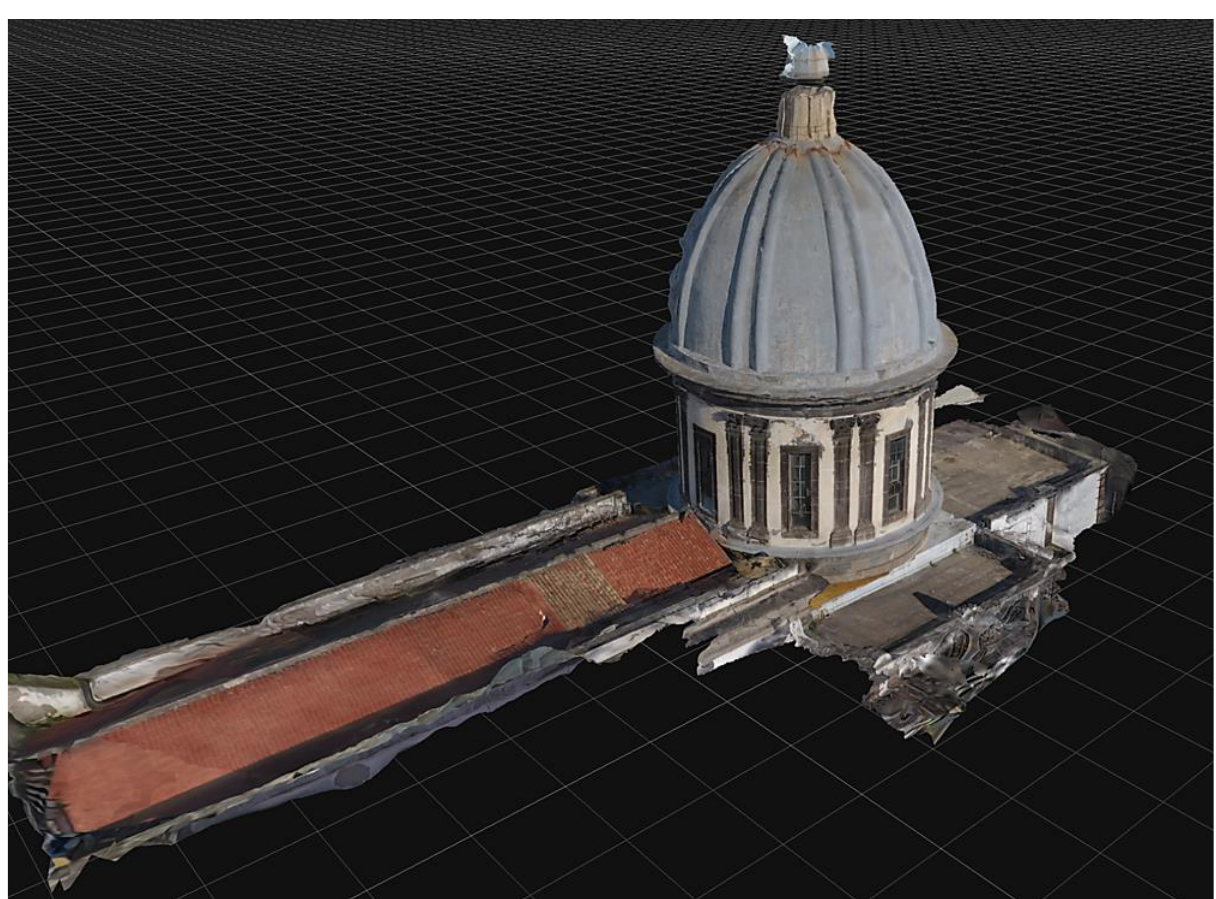
Figure 15. Santa Caterina a Formiello Church. Photomodelling of the roof and the dome elaborated from drone acquisitions